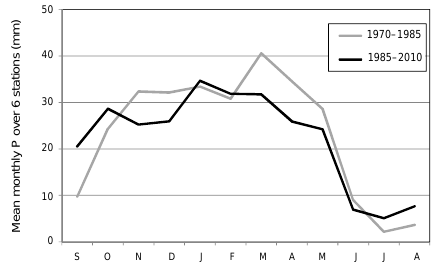
Figure 14. Monthly values of the ratio Q/P averaged over